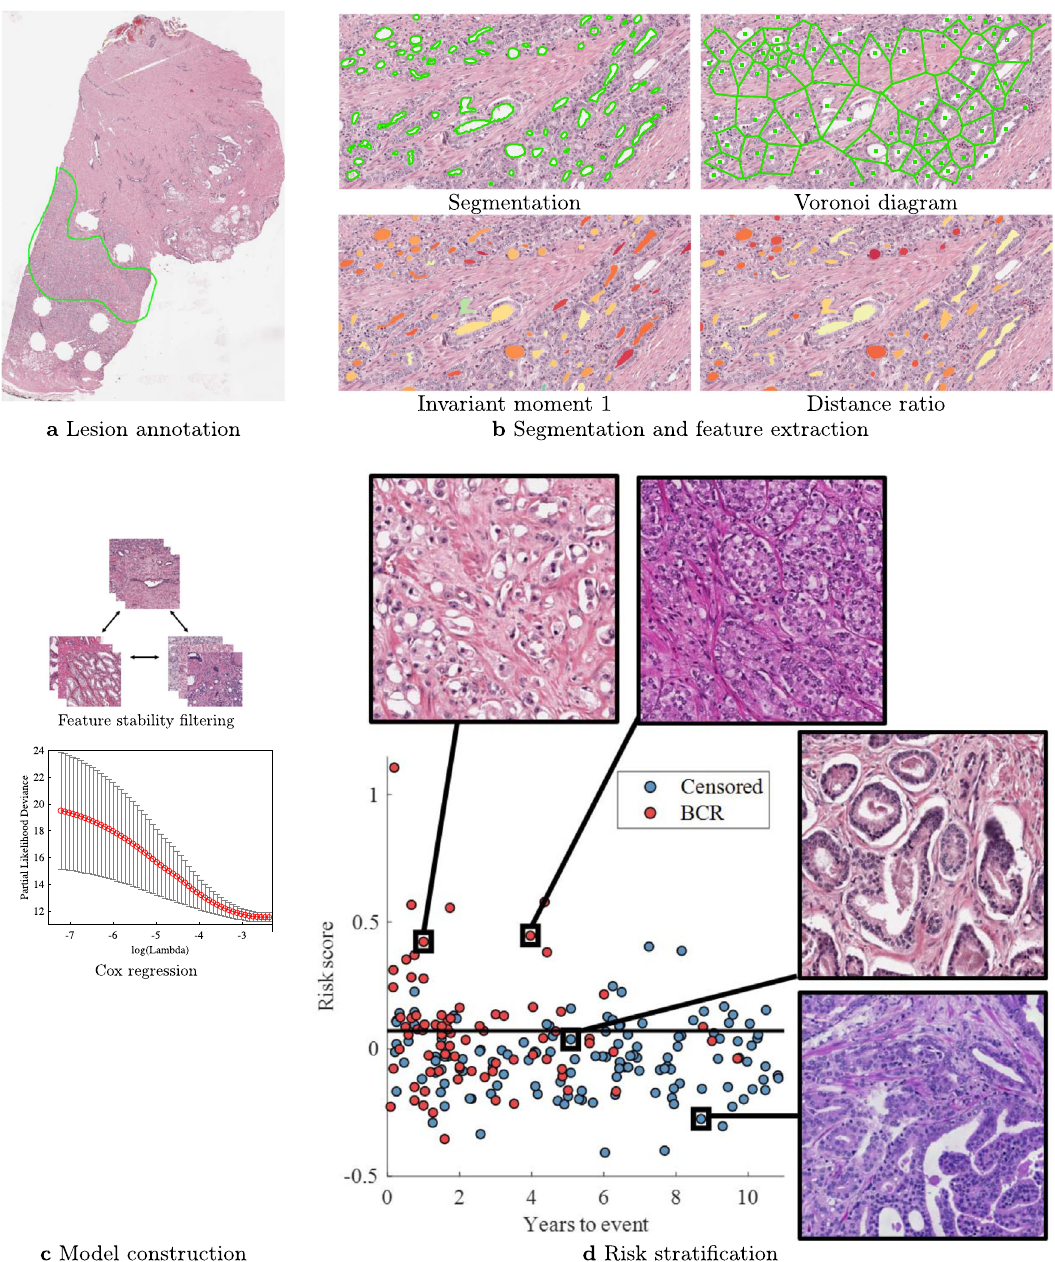
Fig. 7 Diagram of the Histotyping development process. a Pathologist annotation of a representative tumor region on a whole-slide image. b Result of automated lumen segmentation and feature visualizations from a region of interest in the pathologist-annotated tumor region. Shown is a Voronoi diagram, constructed by edges that are equidistant from adjacent glands, the fi rst invariant moment, which is equivalent to moment of inertia, and the distance ratio, which is the ratio of a gland ’ s average radius to its maximum radius. In the invariant moment 1 and distance ratio fi gures, glands are shaded from yellow to red according to their feature values. c Steps of model training, where features are fi ltered for stability using the three cohorts of the training set. A Cox regression model was then fi tted using 10-fold elastic-net regularization. d Results of model training. Each patient of the n = 214 training set is represented as a dot in the scatter plot, with patients who had BCR as red dots and censored patients as blue dots. Dots are located on the x -axis at their time of BCR or time of last PSA test and on the y -axis at their Histotyping risk score from the Cox regression model. The strati fi cation threshold identi fi ed on the training set is shown as a horizontal black line and was then used to classify patients as low-risk or high-risk. Regions of interest from patients at various risk scores are shown in